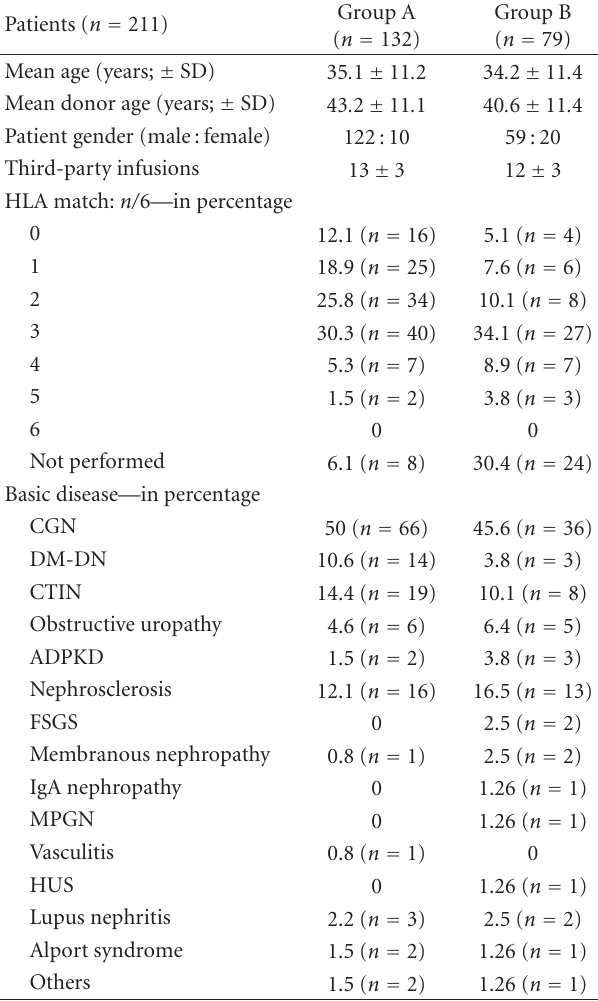
Figure 1: Tolerance induction paradigm for HCV-positive patients. Table 1: Demographics of renal transplant HCV-positive patients (group A) and control patients (group